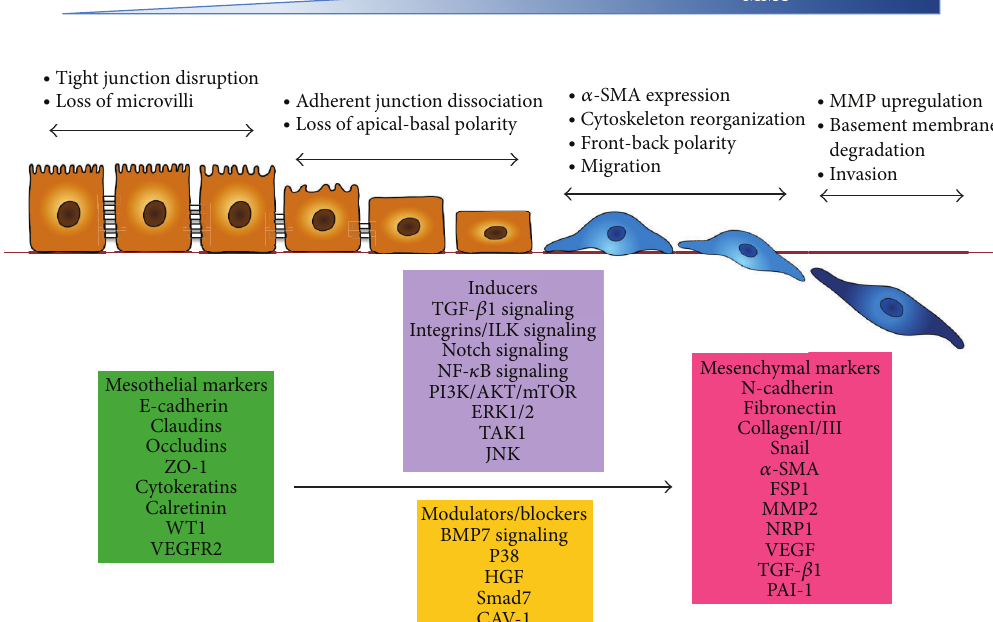
Figure 3: Schematic illustration of the key events during MMT. Mesothelial to mesenchymal transition (MMT) occurs when mesothelial cells lose their epithelial-like characteristics, including dissolution of cell-cell junctions, that is, tight junctions, adherens junctions and desmosomes, and loss of apical-basolateral polarity, and acquire a mesenchymal phenotype, characterized by actin reorganization and stress fiber formation, migration, and invasion. The diagram shows four key steps essential for the completion of entire MMT, the most commonly used mesothelial and mesenchymal markers, and the molecules and signal transduction pathways that act either as inducer or modulator of the MMT process. See text for